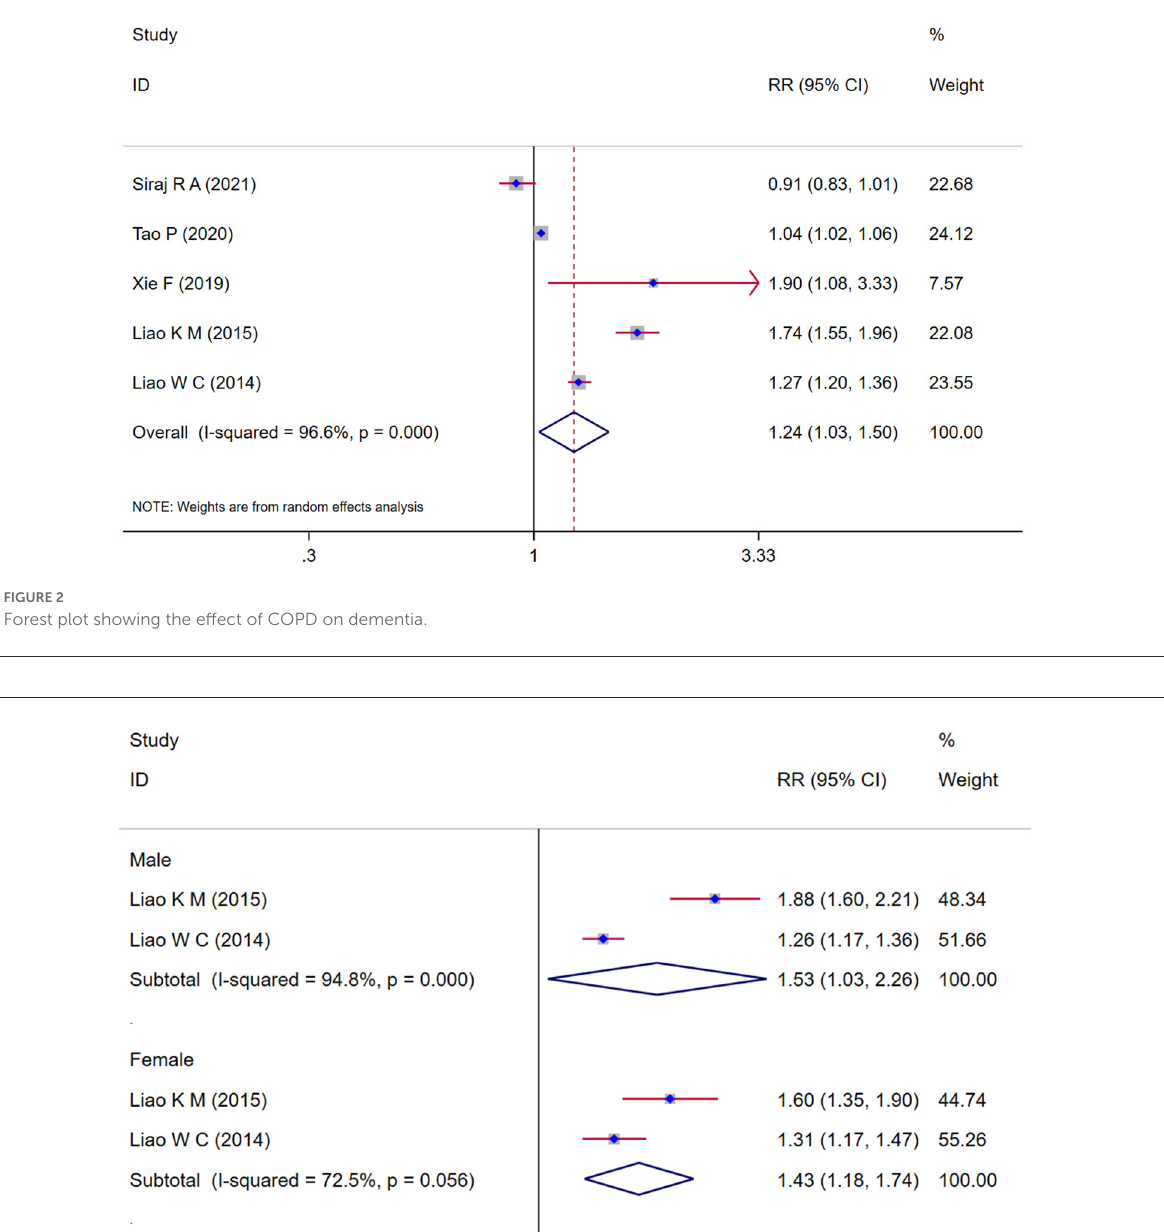
COPD and the risk of cognitive impairment in our